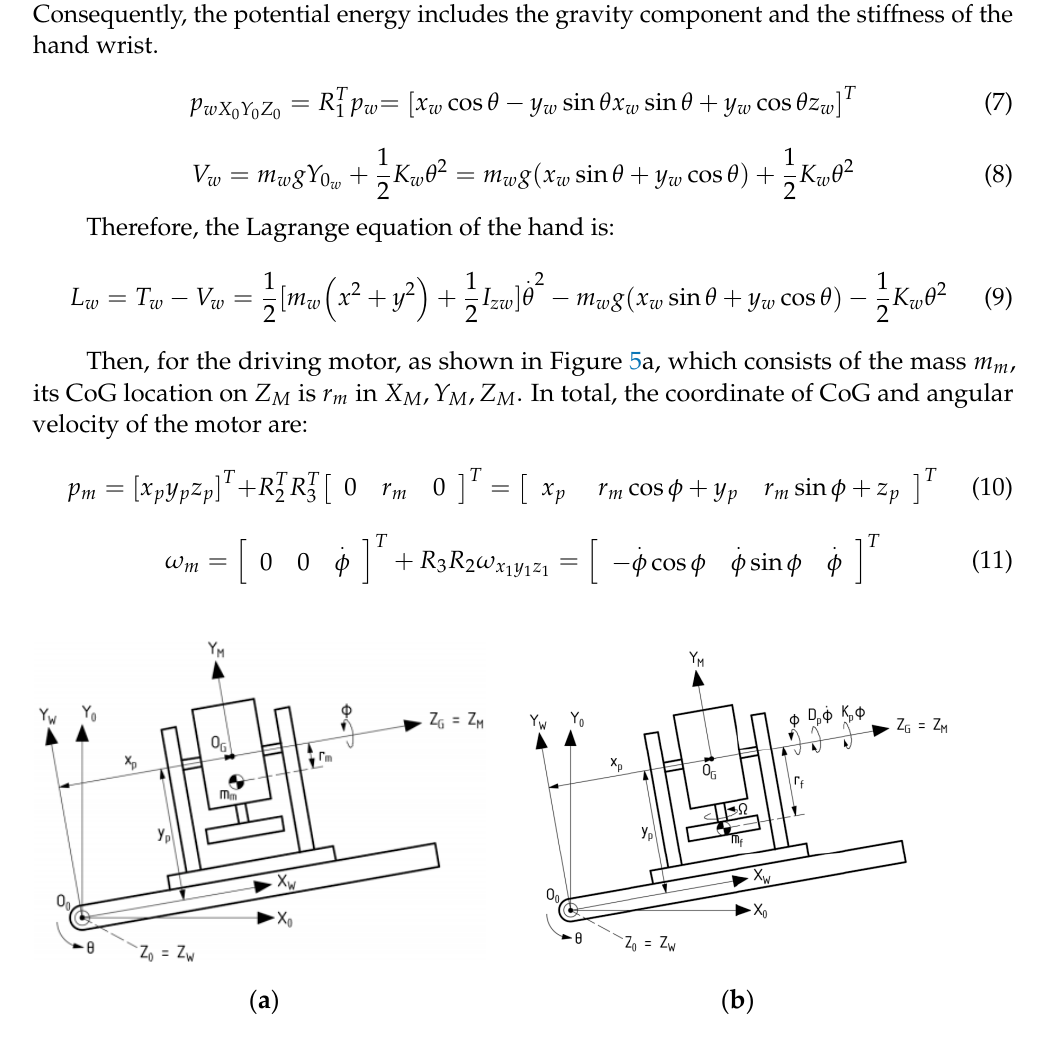
Figure 5. Analysis of the system parameters for ( a ) driving motor and ( b ) flywheel.